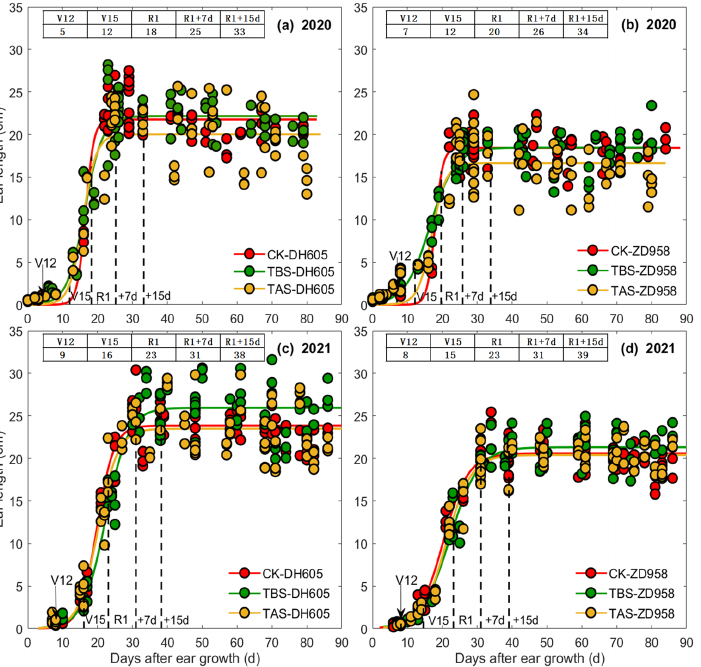
Figure 2. Ear lengths of DH605 ( a , c ) and ZD958 ( b , d ) at different development stages under different heat stress treatments in 2020 ( a , b ) and 2021 ( c , d ). Scatter points are all data of three sowing dates for each treatment. Inset tables show the average values of all treatments and three sowing dates. The same as in Figures 3 and 4.